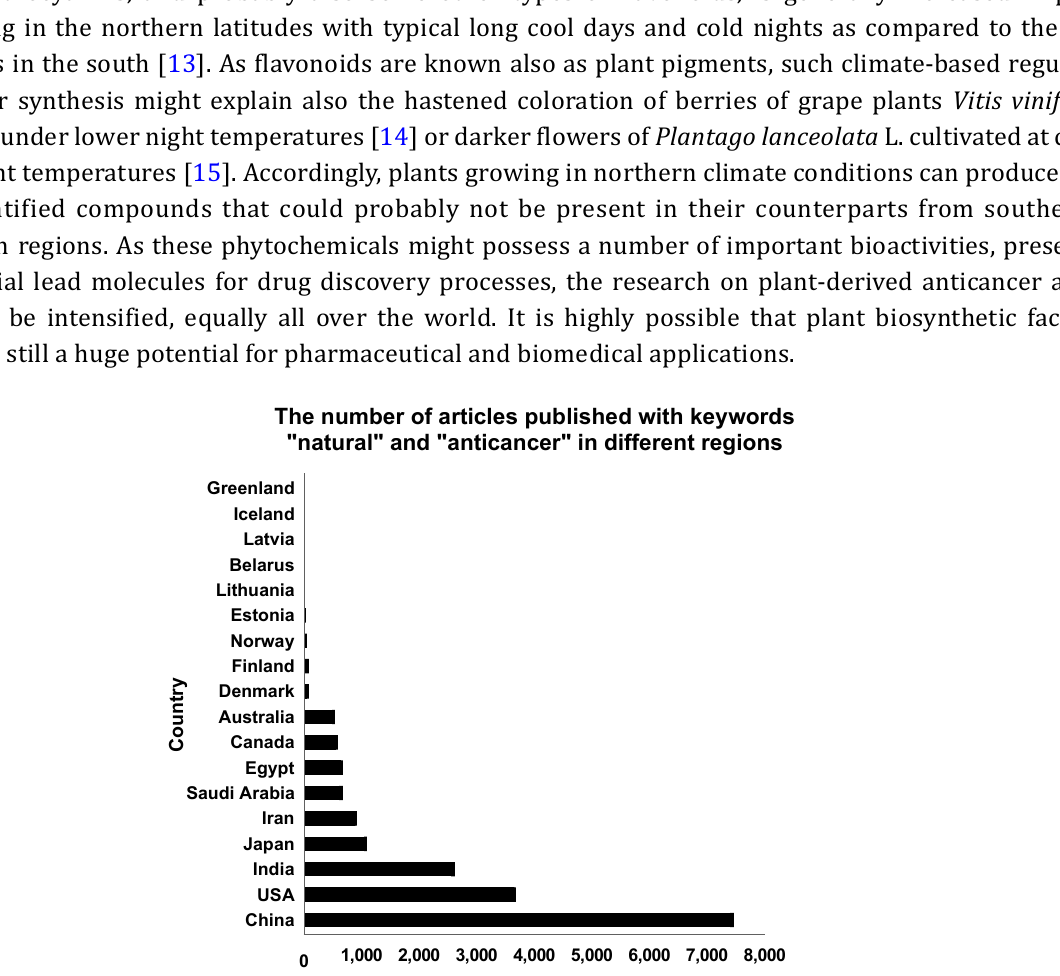
Explor Target Antitumor Ther. 2022;3:423–7 | https://doi.org/10.37349/etat.2022.00092